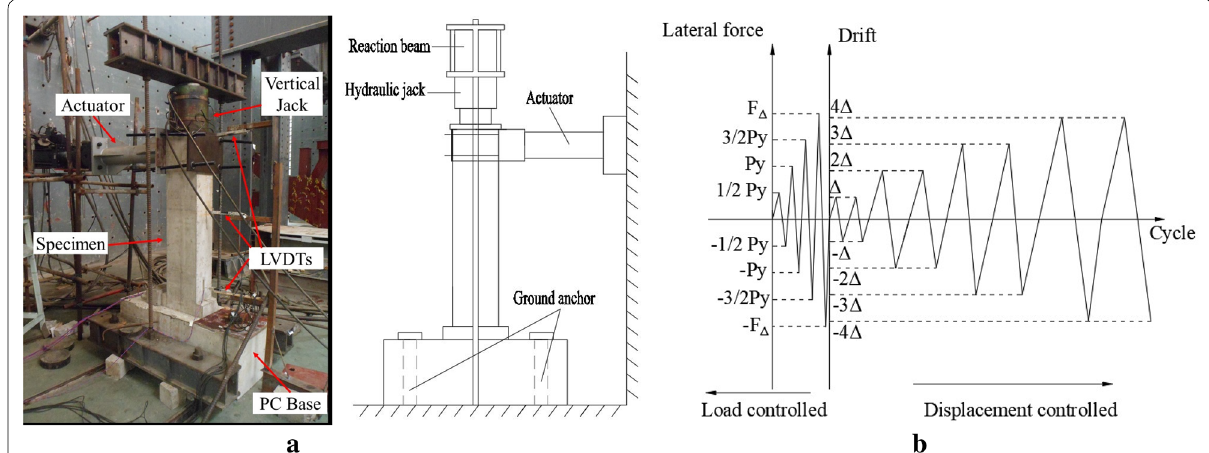
Fig. 5 Test setup and the loading protocol: a test setup; b loading protocol.